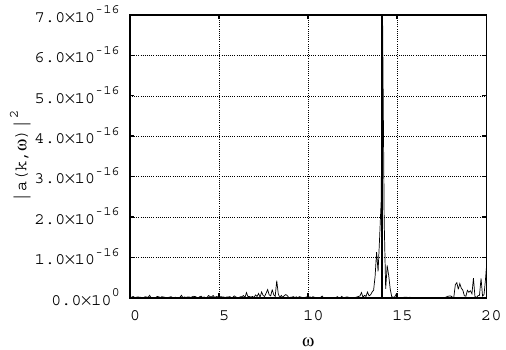
Figure 6. Spectral line of the harmonic k = (0, 200). Both the con- densate and inverse cascade were suppressed.